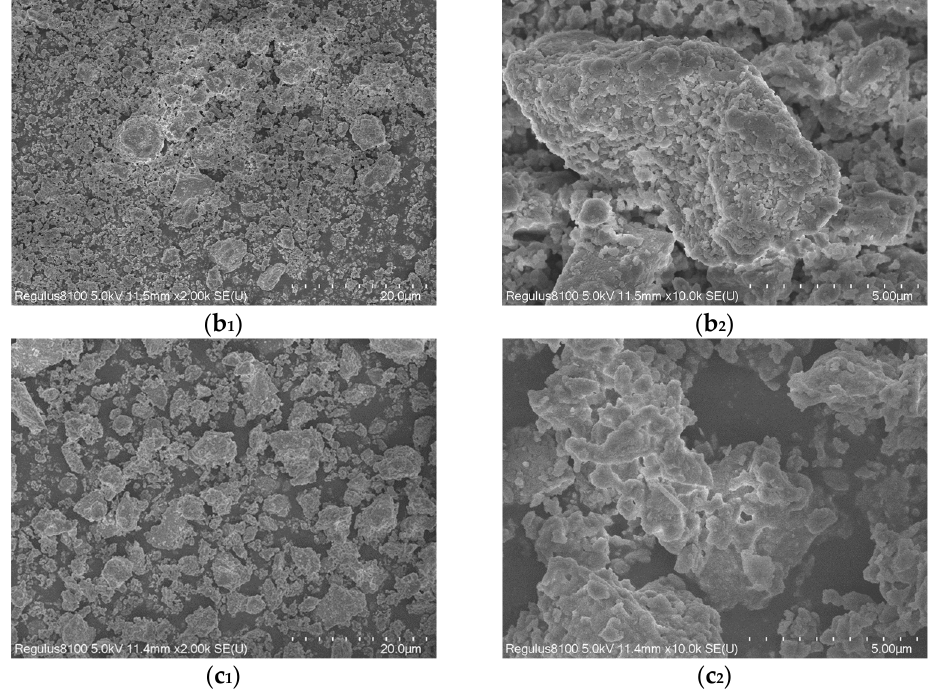
Figure 7. SEM image of kaolin ( a 1 , a 2 ) K00, ( b 1 , b 2 ) K60, and ( c 1 , c 2 ) K62, at 2K× and 10K×, respectively.